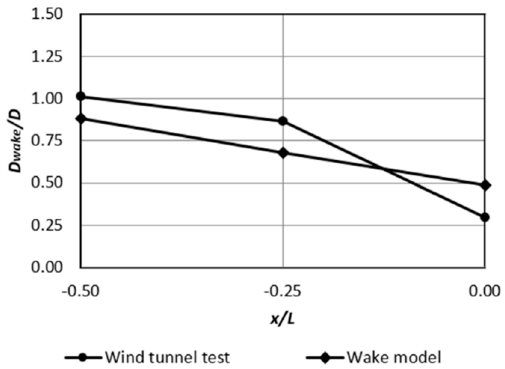
Figure 15. Comparison between the wake width measured in the wind-tunnel test and that estimated using the wake model.